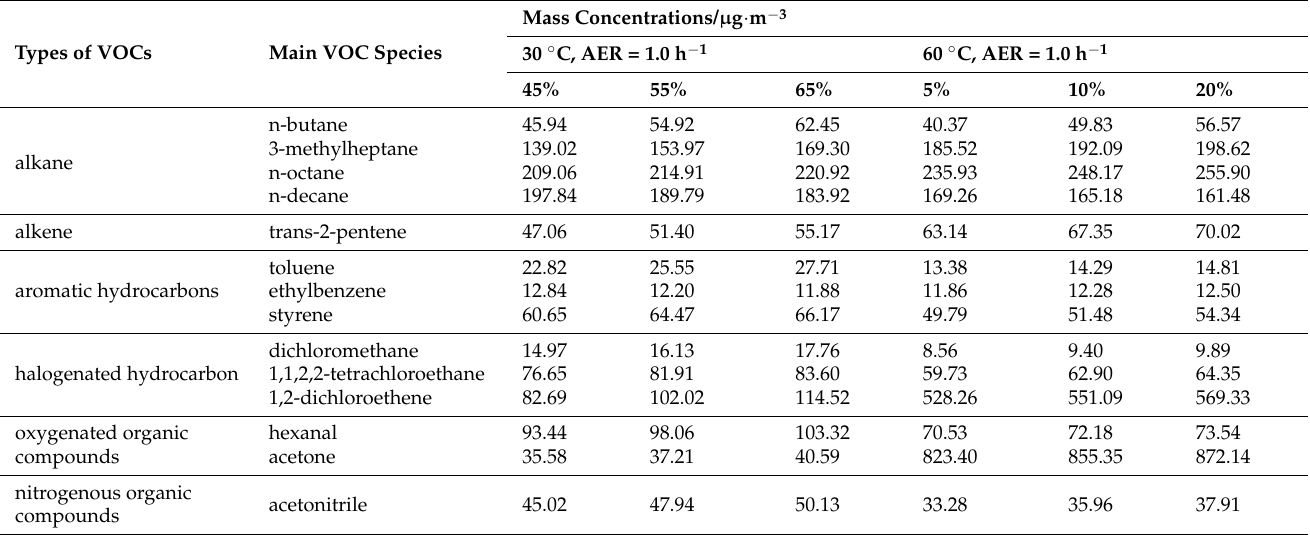
Table 3. Mass concentrations of main VOCs released from plastic track under different values of relative humidity.